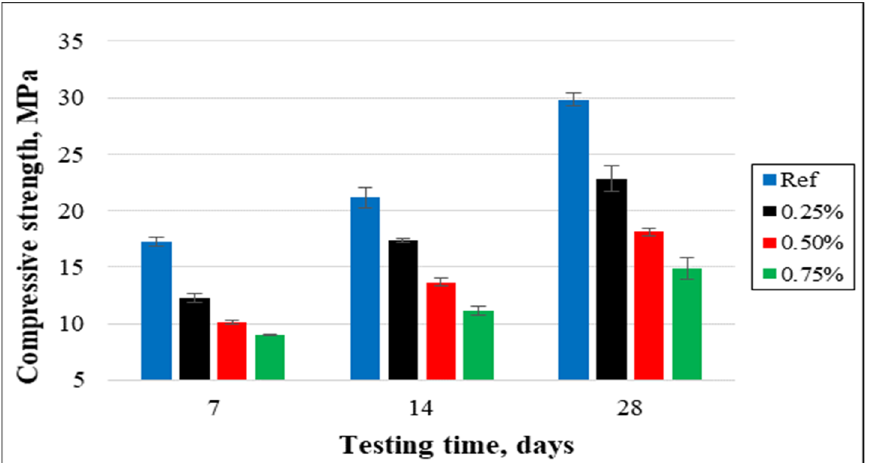
Figure 18. Cube compressive strength of concrete specimens containing cut pieces .